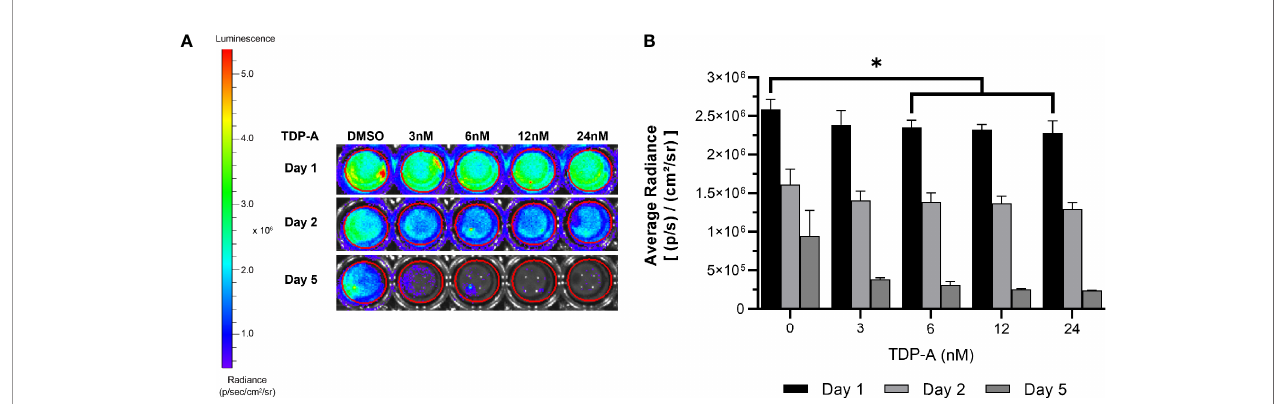
FIGURE 6 | NET cells within ECM require perfusion for survival. (A) Cells from a TT-Luc xenograft were suspended in ECM and plated for culture without perfusion in triplicate. Cells were then treated with varying concentrations of TDP-A (0-24nM) or vehicle control (DMSO). Proliferation of TT-Luc cells over time was determined by luciferase activity. (B) Graphical display of a dose-dependent decrease in cell viability after TDP-A treatment. Wells treated with vehicle control had signi fi cantly higher radiance compared to all TDP-A doses over 3nM at all timepoints, but still exhibited a signi fi cant decrease in viability over the course of the experiment. “ * ” indicates signi fi cance at p < 0.05.